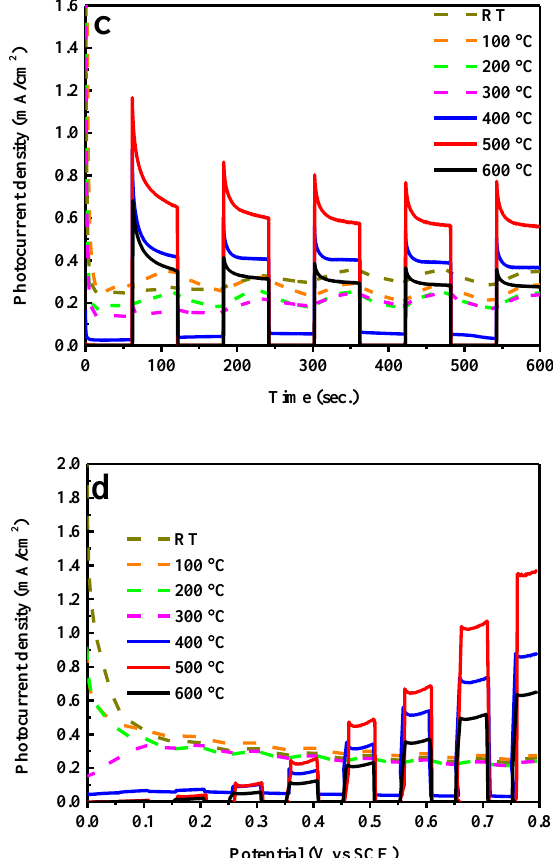
Figure 6. Photo-electrochemical (PEC) performance measurements: Potentiostatic ( a and c ) and potentiodynamic ( b and d ) response of the films obtained at different deposition time and annealing temperatures. Measurements were carried out under intermittent light illumination.